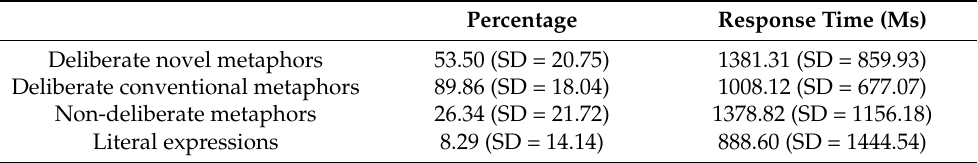
Table 3. Average percentages of perspective adoption and respective response